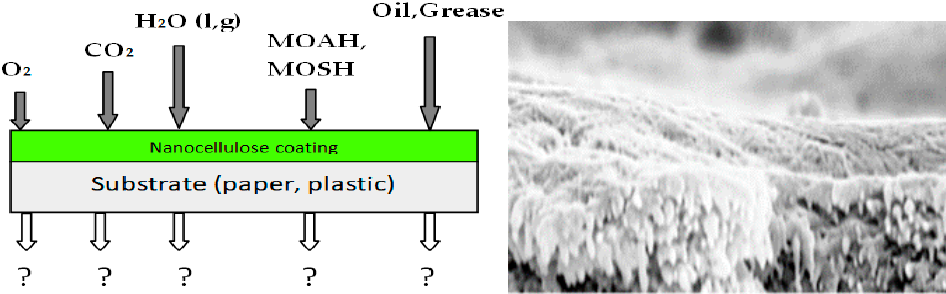
Figure 5. Five types of barrier provided by the nanocellulose (NC) coatings and cross-section SEM of coated polymer. of coated